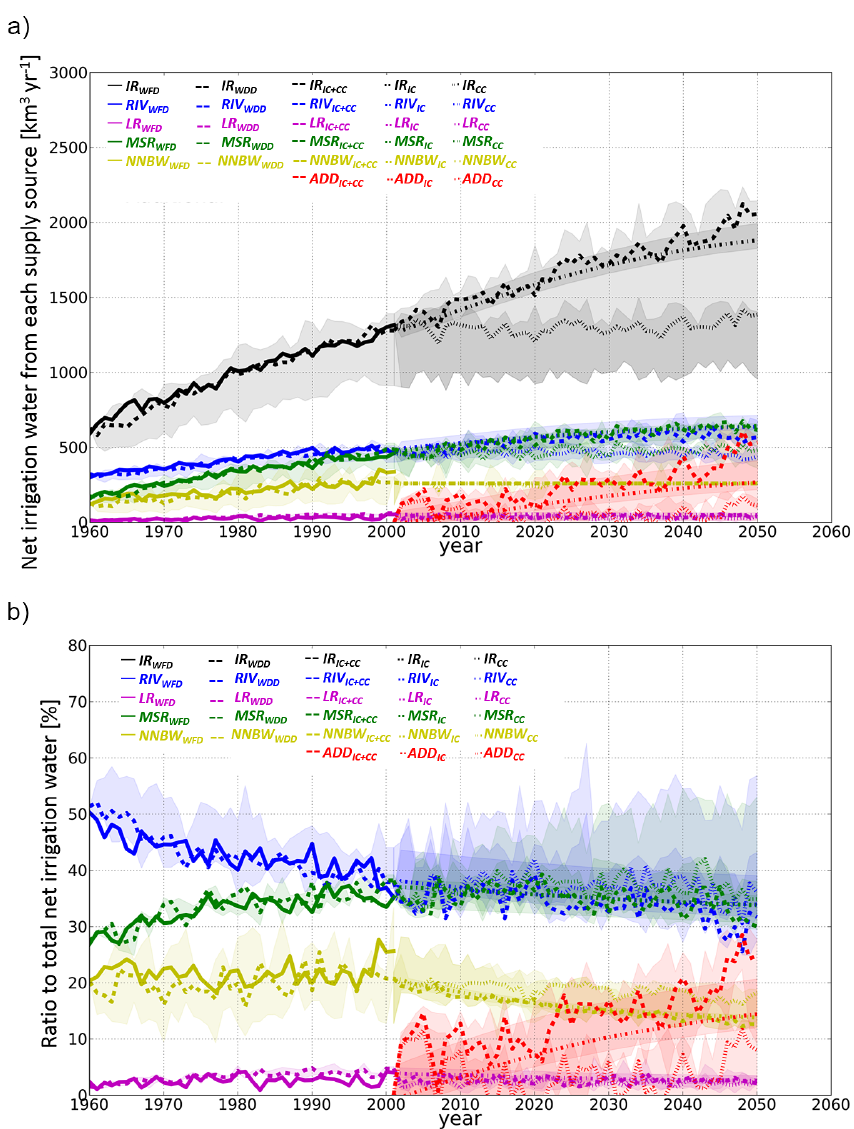
Figure 5. Annual changes in global net irrigation water requirements (km 3 yr − 1 ) from four water supply sources (RIV, LR, MSR and NNBW) using the WFD and WDD data sets for 1960–2001, and global net irrigation water requirements (km 3 yr − 1 ) from five water supply sources according to the IC simulation (RIV IC , LR IC , MSR IC , NNBW IC and ADD IC ), the CC simulation (RIV CC , LR CC , MSR CC , NNBW CC and ADD CC ) and the IC + CC simulation (RIV IC+CC , LR IC+CC , MSR IC+CC , NNBW IC+CC and ADD IC+CC ) for the period 2002–2050 (a) ; the percentage contributions (%) of different water supply sources to the total IR (b) . In the past and future periods, results of the ensemble median for the WDD data set of three GCMs are provided. Outer shades show the maximum and minimum for the all meteorological forcing